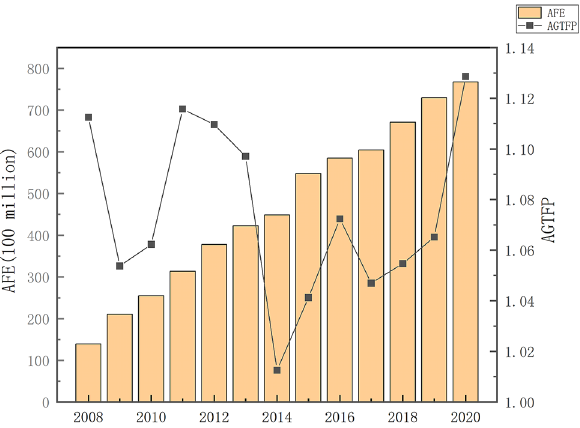
Figure 6. Characteristics of AGTFP and AEF temporal changes from 2008 to